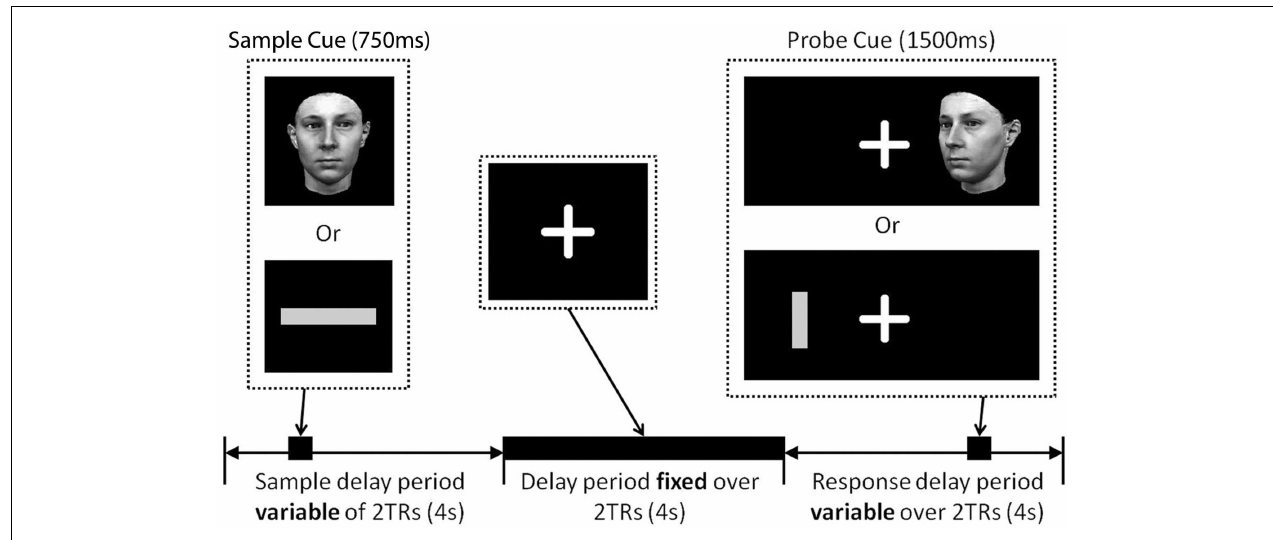
presented left or right of the fixation cross (stimulus onset jittered 0–2500ms from the onset of the fifthTR). Participants responded as quickly possible at the presentation of the probe cue making either a left/right judgment or a match/non-match judgment. Face and line probe cues were presented in a different orientation to the sample